Question: Sum up the contents of this chart in one sentence.
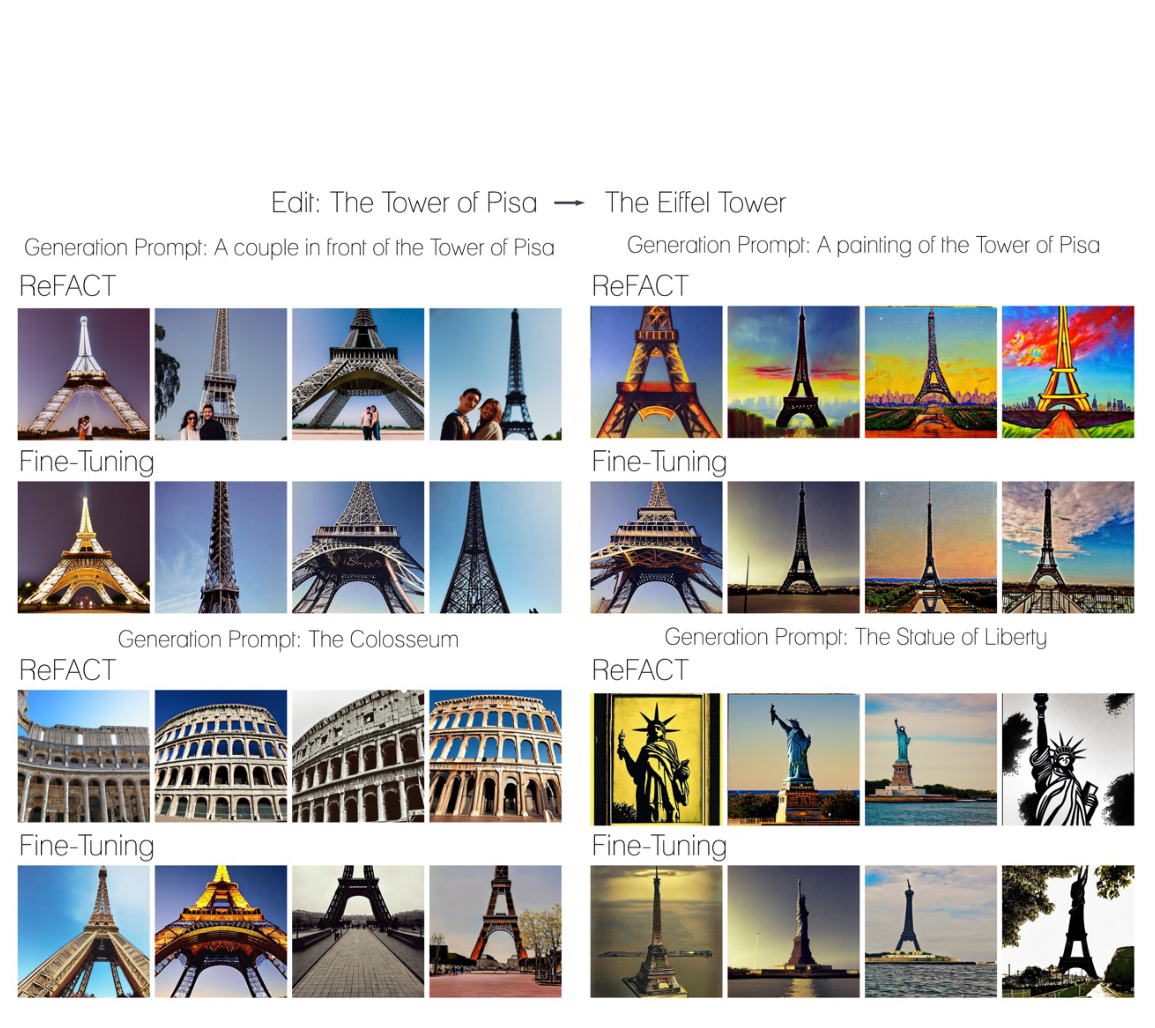
Answer: Fine-tuning baseline compared to ReFACT. Fine-tuning exhibits catastrophic forgetting in complex prompts by neglecting to generate some concepts (e.g., “A couple”), and demonstrates poor specificity by affecting unrelated concepts (e.g., “The Colosseum”).